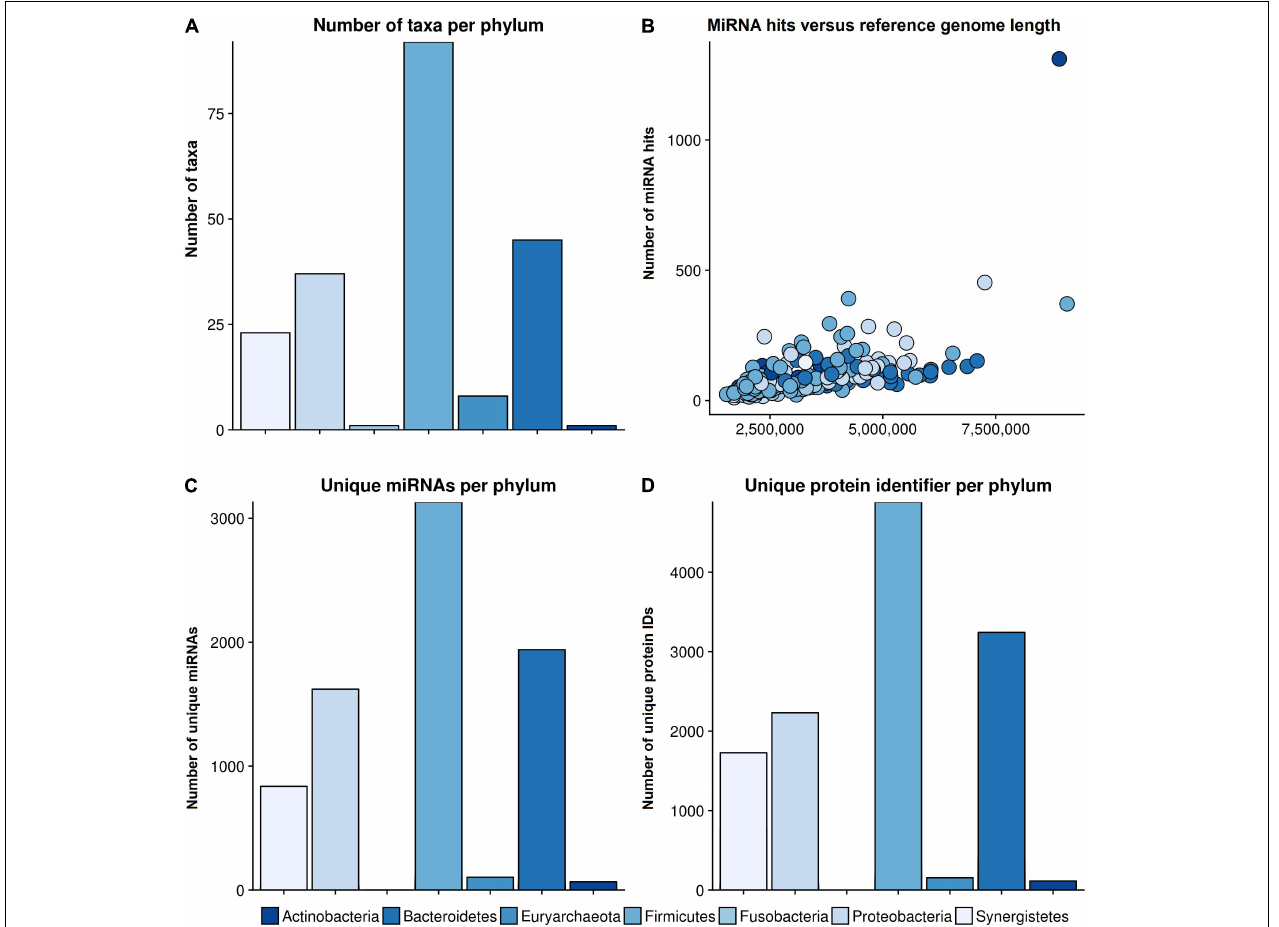
FIGURE 3 | General results of the target scan. (A) The species composition of our genomic reference database. (B) The number of miRNA hits plotted against the reference genome length of the different phyla. (C) The number of miRNAs that revealed hits with a bacterial organism is shown per phylum, and (D) the number of unique protein IDs, which were predicted to have putative target sites for miRNAs, in different phyla. The colors refer to different phyla. The legend for all graphs is given beneath the lower